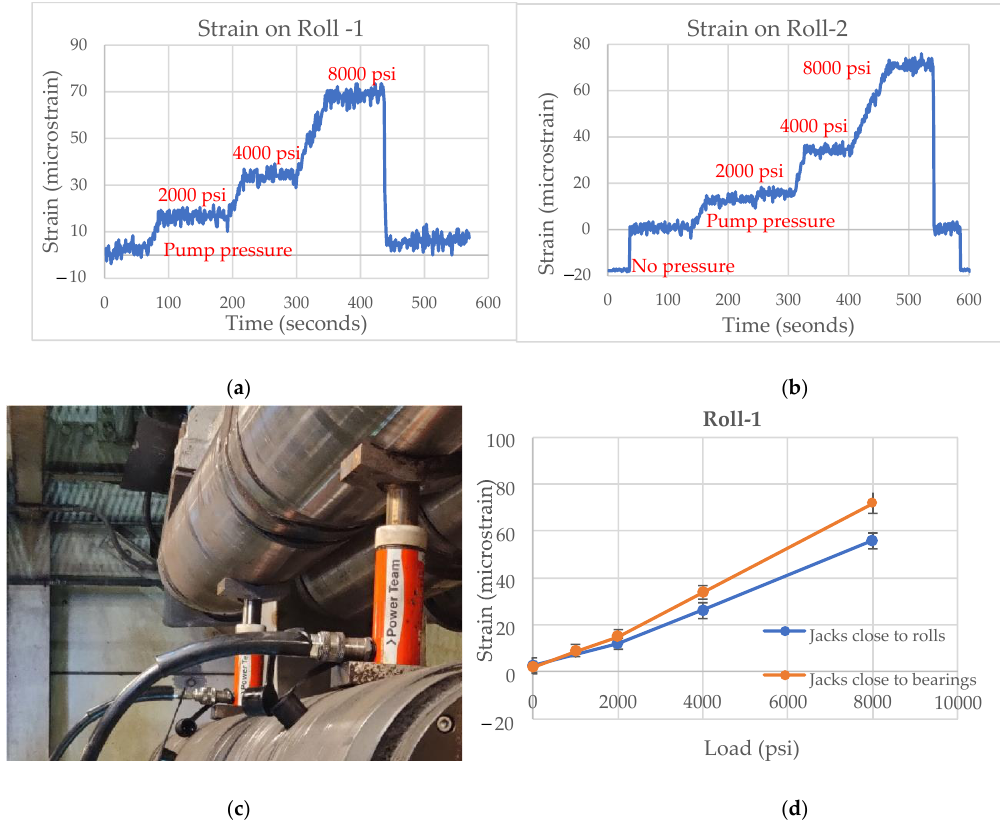
Figure 14. ( a ) Strain measured by Roll-1 with single hydraulic jack. ( b ) Strain measured by Roll-2 with single hydraulic jack. ( c ) Hydraulic jacks placed close to rolls. ( d ) Strain with respect to load (psi) on Roll-1.